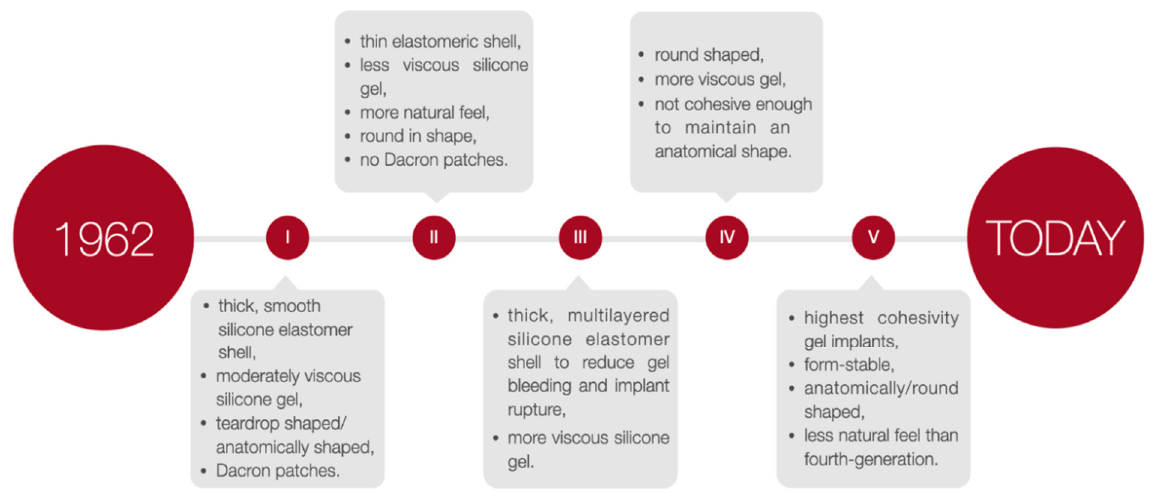
Figure 3. The generations of silicone breast implants.